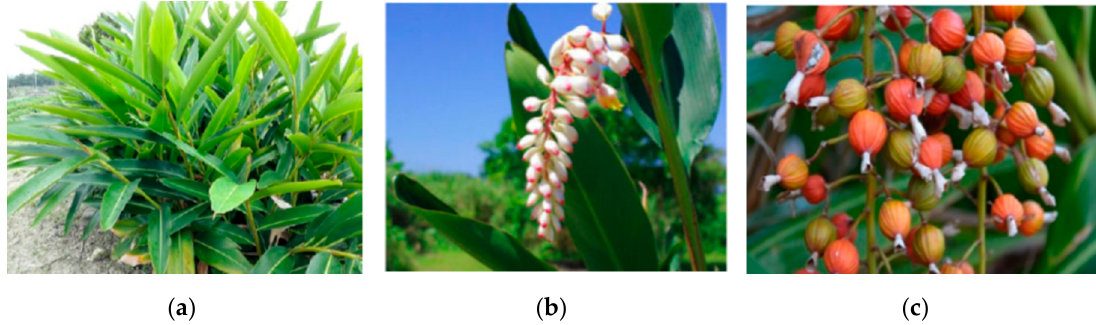
Figure 2. Photos of Alpinia zerumbet plant ( a ), flower ( b ) and fruits ( c ). Adapted from [116].